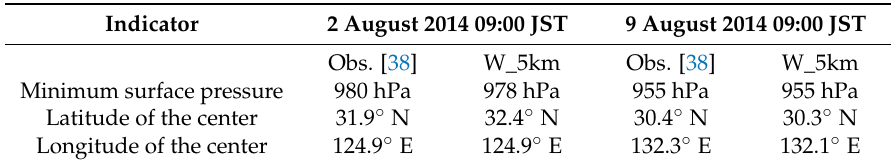
Figure 5. Spatial distributions of hourly precipitation obtained from Radar/Raingauge-Analyzed Precipitation data at 09:00 JST on ( a ) 2 August 2014, ( b ) 9 August 2014, ( c ) 22 August 2014, and of hourly precipitation and wind fields obtained from W_5km case at 09:00 JST on ( d ) 2 August 2014, ( e ) 9 August 2014, and ( f ) 22 August 2014. The Radar/Raingauge-Analyzed Precipitation data covers areas within a few hundred kilometers from the coastal lines of Japan. Table 3. Observed and simulated minimum surface pressures and their positions of typhoons at 09:00 JST on 2 and 9 August